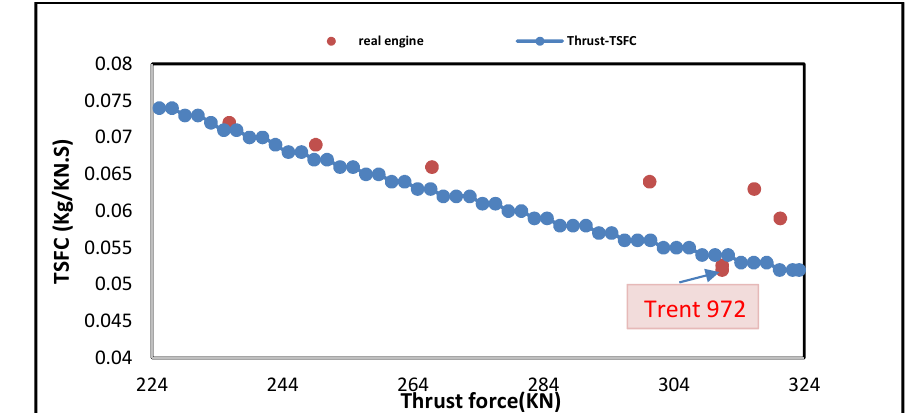
Fig. 8. Trade-off curve four between engine thrust force and TSFC with real engines.